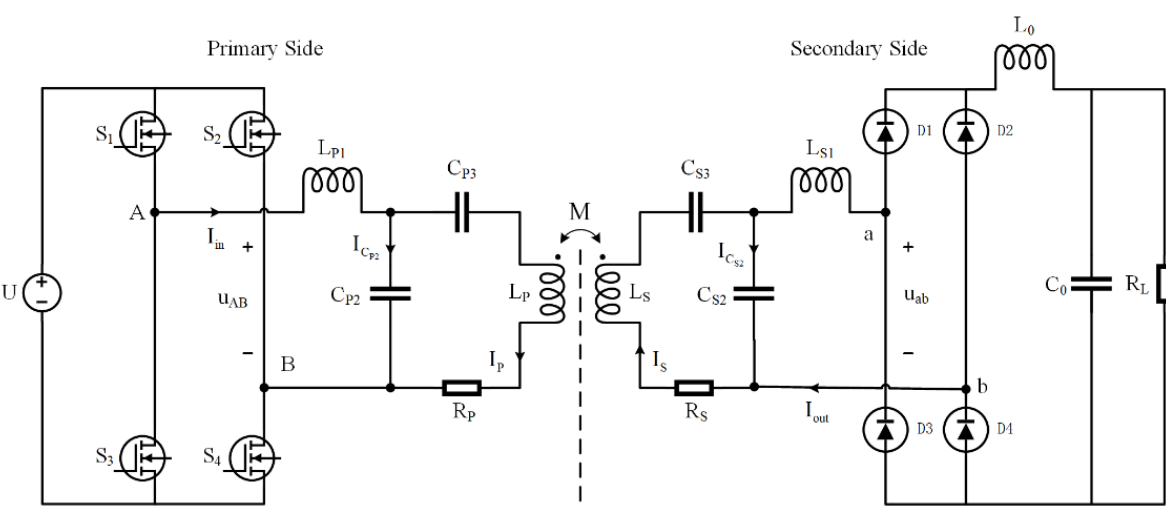
Figure 2. Double-sided LCC compensation topology for WPT system.